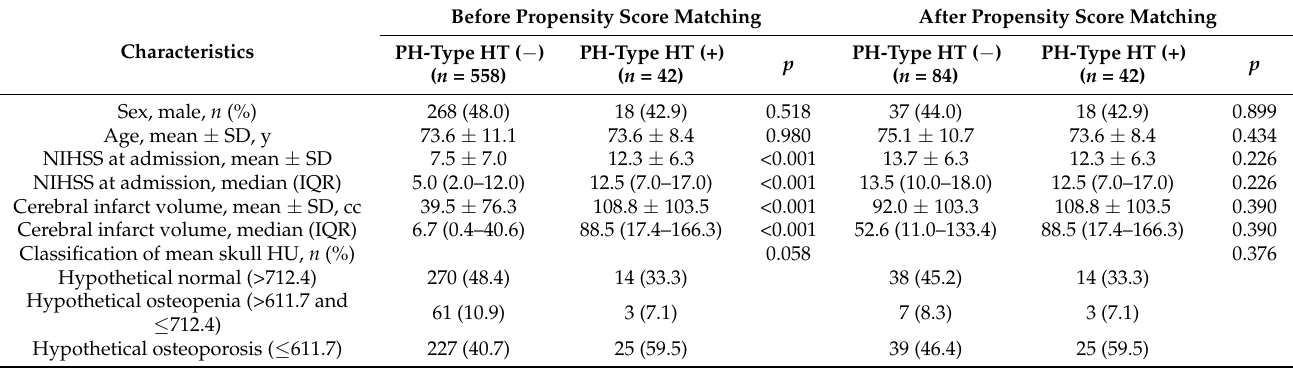
Table 3. Characteristics of patients with cardioembolic cerebral infarction classified according to the presence of PH-type HT before and after propensity score matching based on the sex, age, stroke severity (NIHSS), and infarction volume.